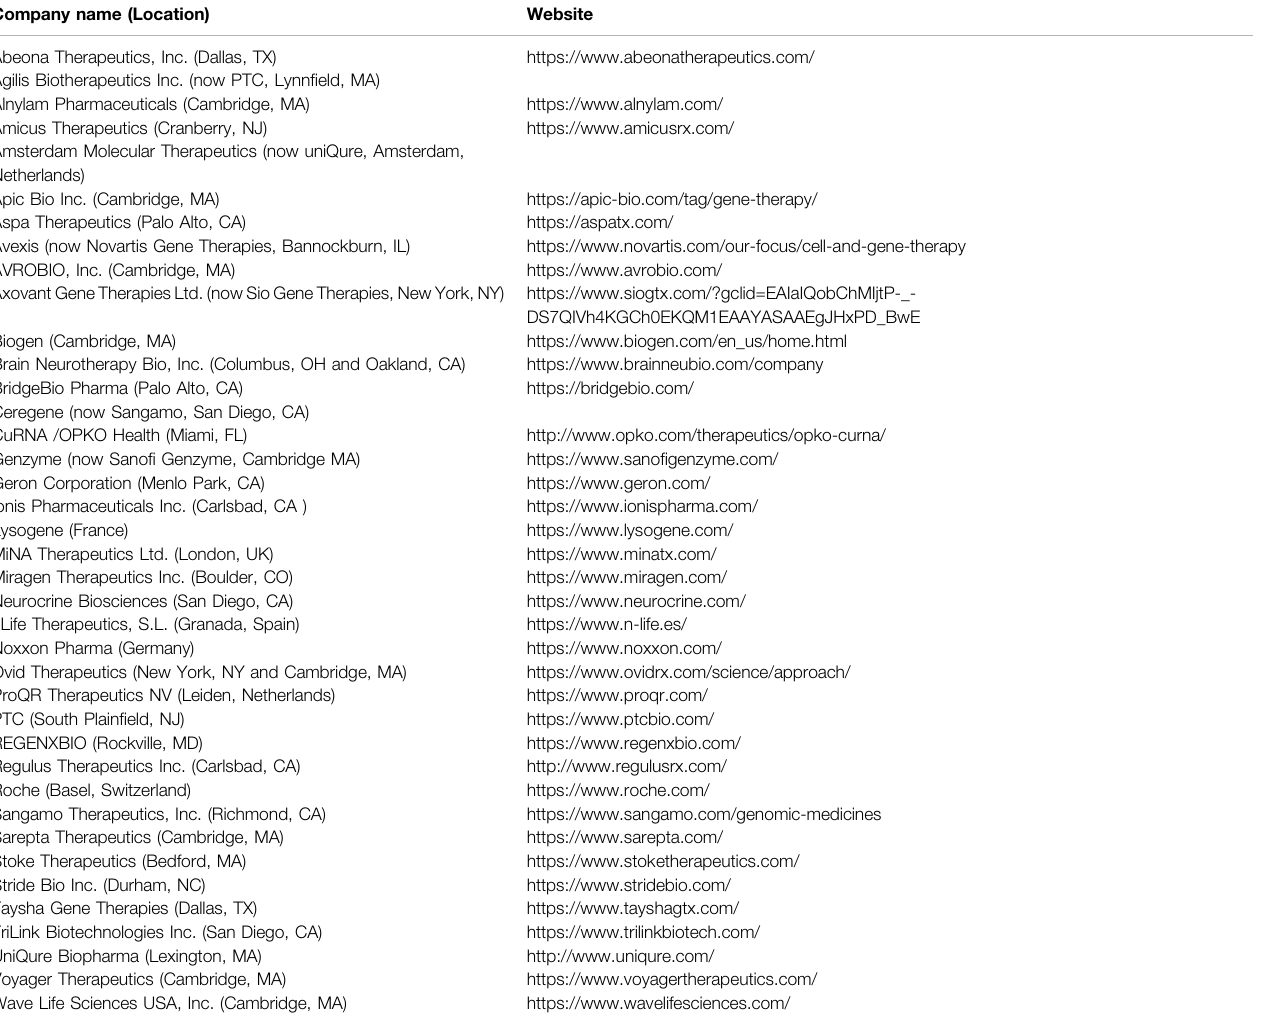
TABLE 3 | List of companies mentioned in the